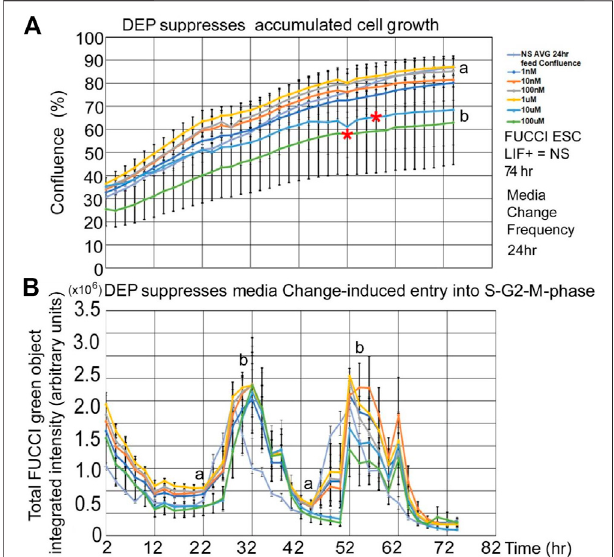
FIGURE7| DEPsuppresses accumulatedgrowth asalagging indicator measured by con fl uence and suppresses entry into the S-G2-M phase after medium change as a leading indicator predicted during ESC culture with LIF. FUCCI ESCs are cultured and assay as shown in Figure 1 , but the indicated doses of DEP were added to LIF + media. (A) Con fl uence was measured in time-lapse every two hours in the live imager as described previously but here doses of 0 DEP and 1 – 100nM and 1 – 100uM DEP were used in LIF + culture. Red asterisks show when con fl uence starts to signi fi cantly differ from NS. For higher doses, the divergence points are realized earlier (T58for 10 uM and T52 for 100 uM). The rest of the doses are notsigni fi cantlydifferentthanNSatT74. (B) Simultaneously,con fl uencegreen fl uorescencewasmeasuredintime-lapseeverytwo hintheliveimager.Green intensity increases (cells enter the S-G2-M phase) after cells are fed at approximately T24 and T48. Increasing dose of DEP suppresses the number of cells in the S-G2-M phase, suppressing peaks. Offsets in the timing of the zero dose and the rest of the curves are due to feeding differences between experiments. NS (0 dose): N described in Figure 1 . DEP: three biological experiments, N (cid:1) 6. (a) is statistically different from